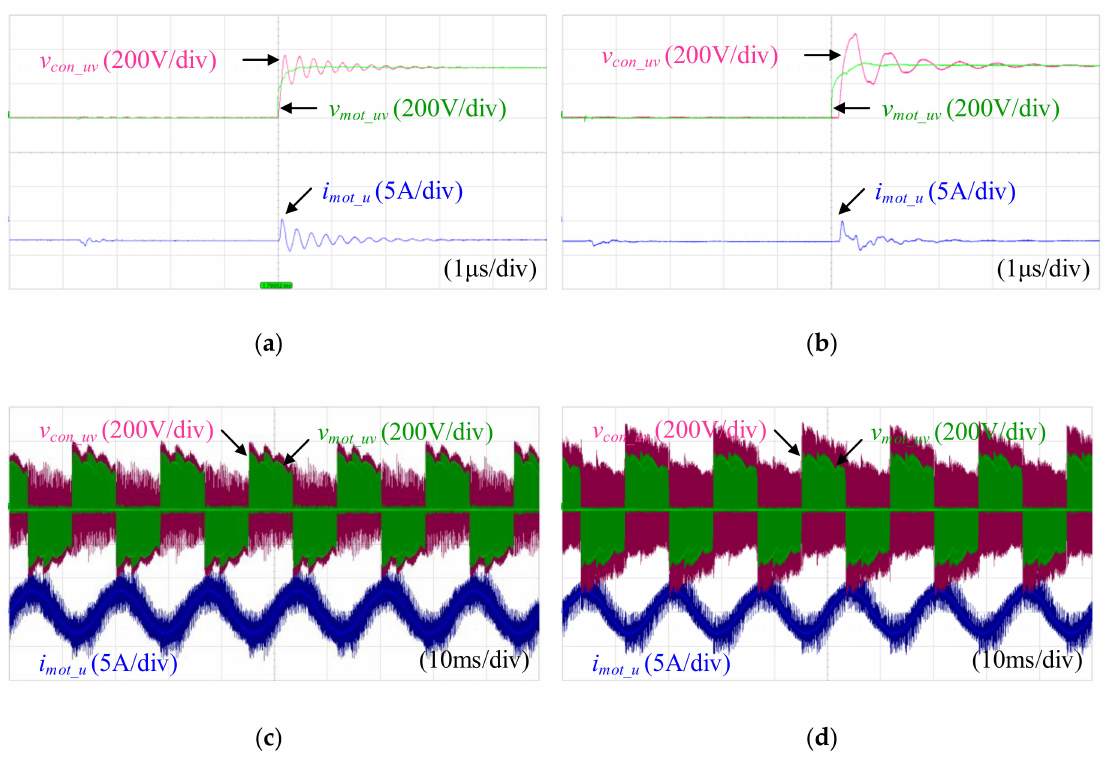
Figure 10. Measurement results of GaN-based VFD without filter. ( a , c ) 5-m cable and ( b , d ) 25-m